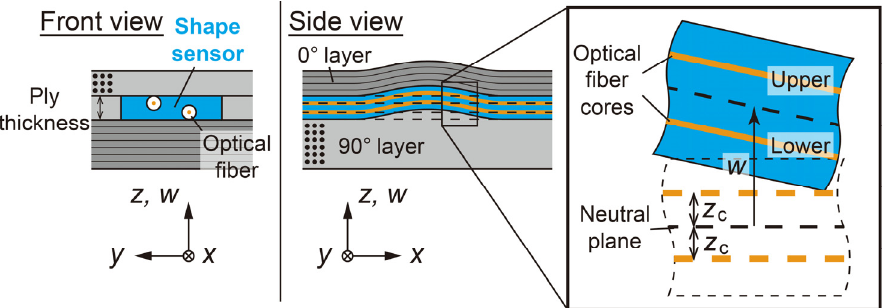
Figure 2. Schematic of strip-type shape sensor embedded in composite.